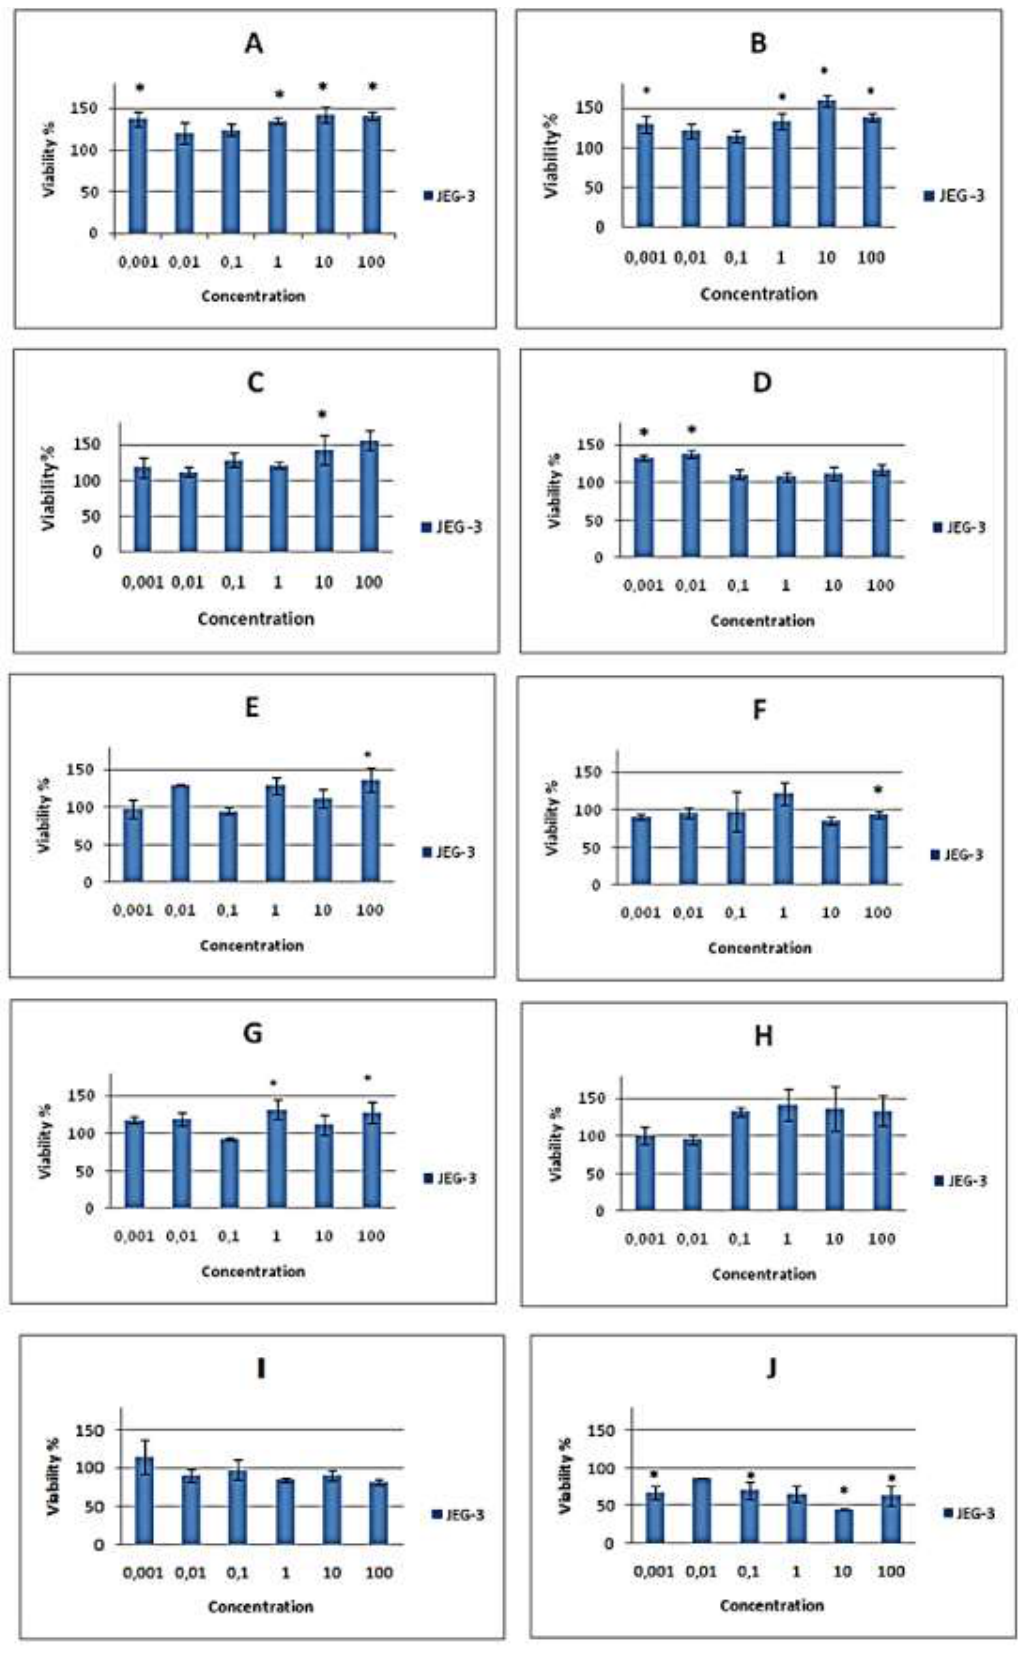
Figure 2. Effects of short-term (24 h) treatment of different concentrations of steroidal imidazoheterocycles on JEG-3 choriocarcinoma cell